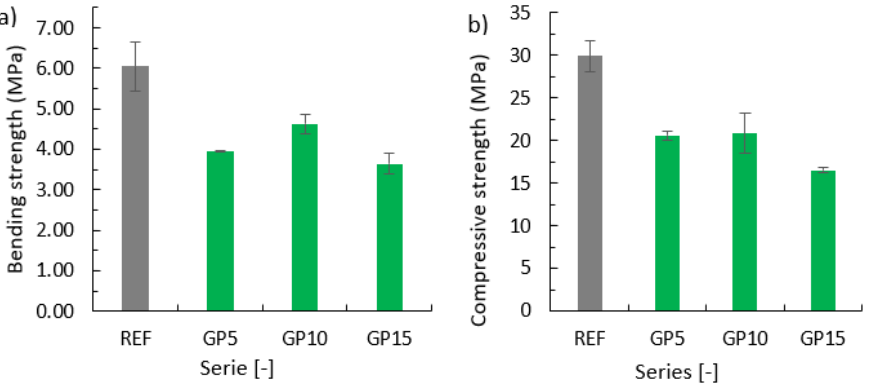
Figure 3. Properties of the hardened cementitious mortars with a partial replacement of cement with the granite powder: ( a ) bending strength; ( b ) compressive strength.